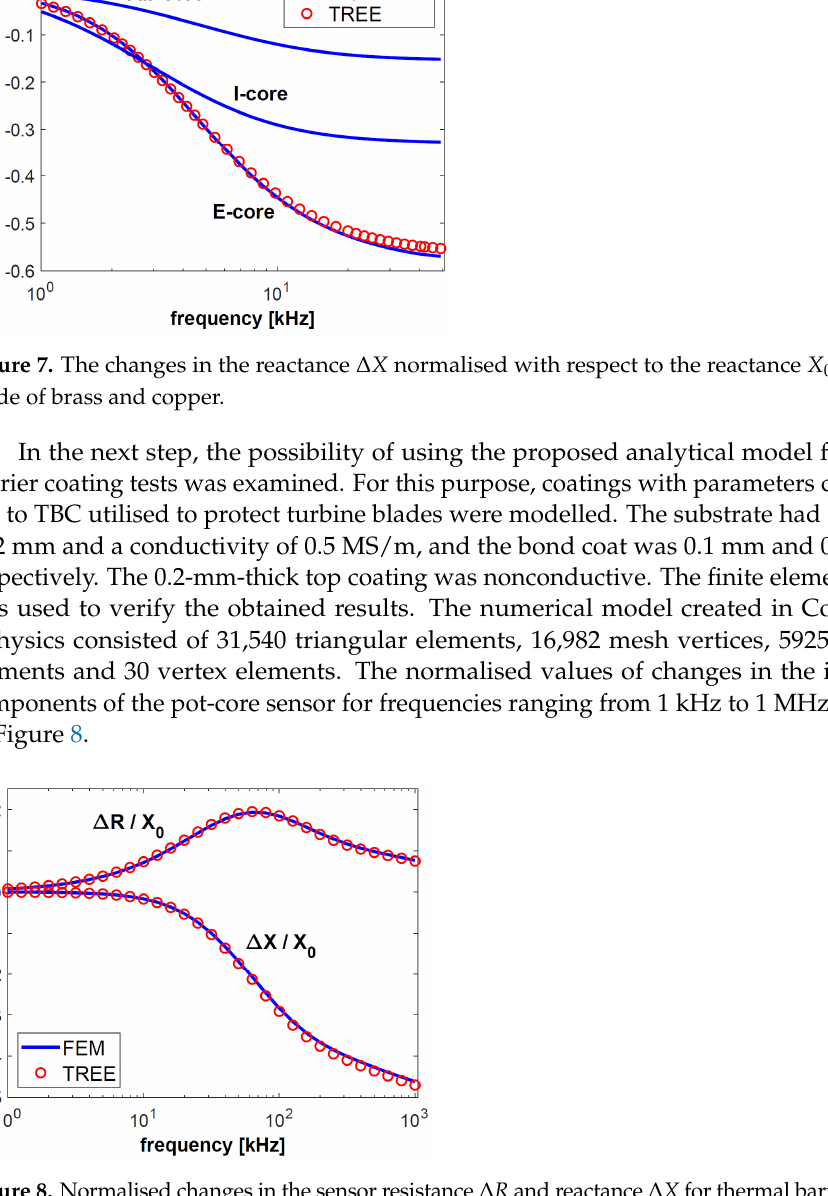
Figure 8. Normalised changes in the sensor resistance ∆ R and reactance ∆ X for thermal barrier